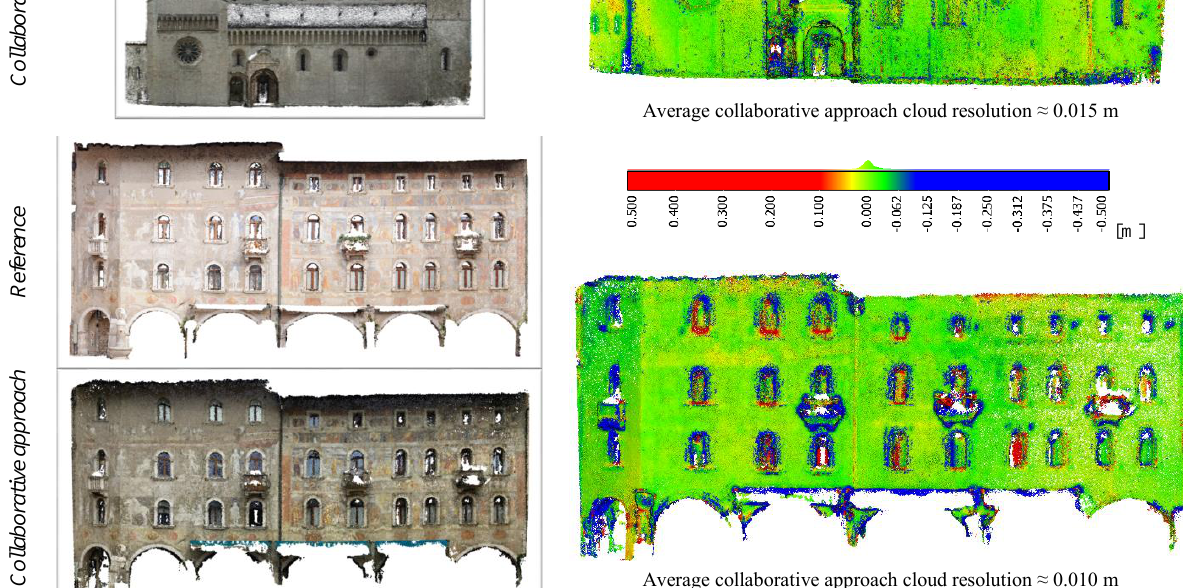
Figure 7: Quality evaluation of the proposed collaborative approach. On the left column, for each dataset the dense point clouds from the reference 3D reconstruction and the collaborative approach are shown. The right column shows the colour-coded map of the signed distances computed between the reference and the collaborative dense point clouds. The given differences are in